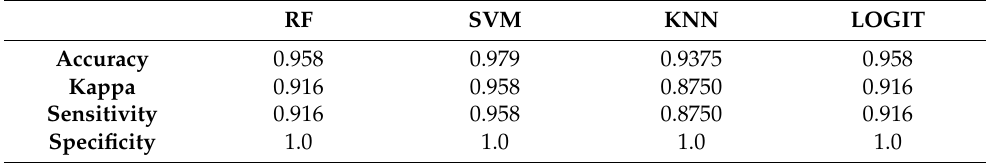
Table 4. Summary table of classification accuracy, sensitivity, specificity, and Kappa values in the test set by each applied method. KNN: k-nearest neighbors, RF: random forest, LOGIT: logistic regression, and SVM: support vector